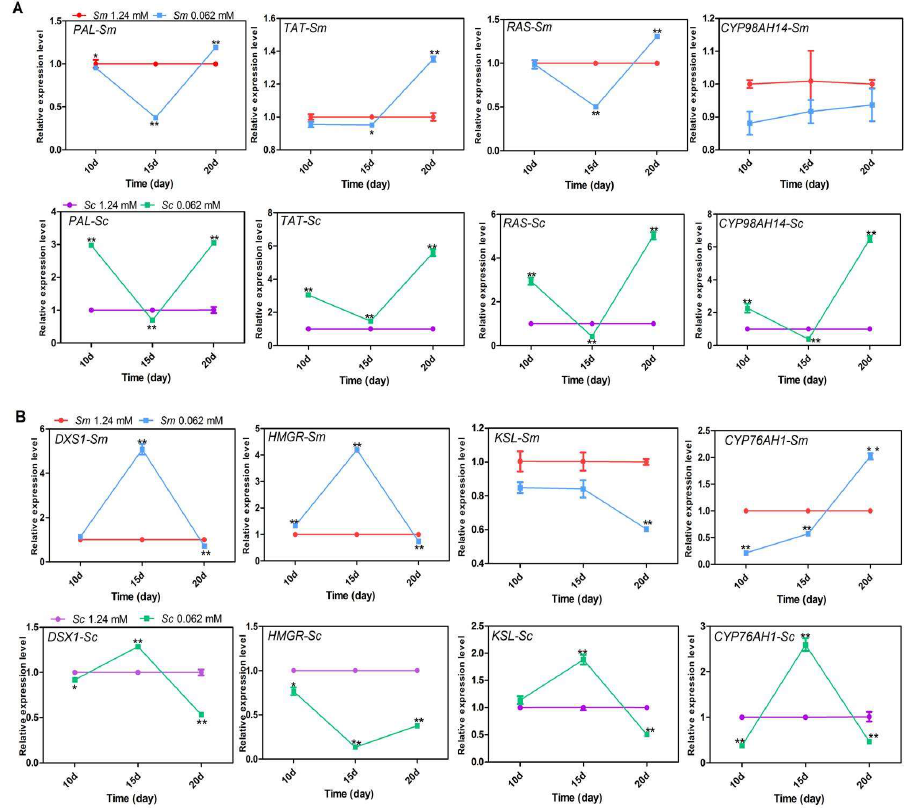
Figure 3. Quantification of the transcript levels of key enzyme genes in hairy roots under control and Pi-deficient conditions at different times (10th, 15th, 20th day). Quantification of the transcript levels of key enzyme genes were calculated in relation to β-actin reference gene transcript levels. ( A ) Genes involved in phenolic acid biosynthesis. ( B ) Genes involved in tanshinone biosynthesis. Sm , S.